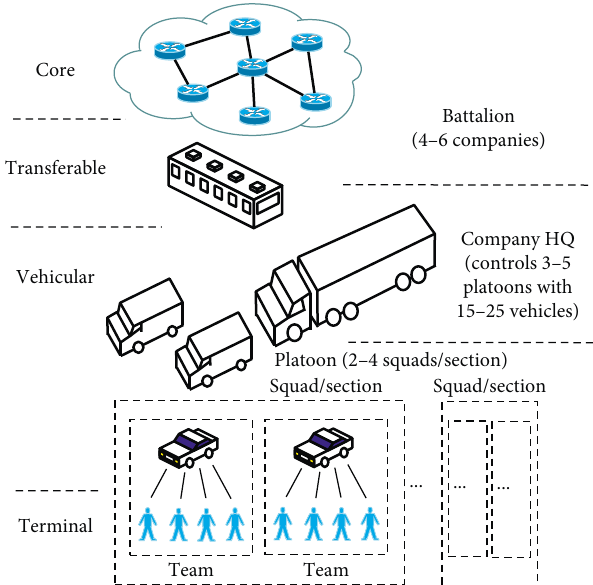
Figure 2: Military hierarchy in relation to node